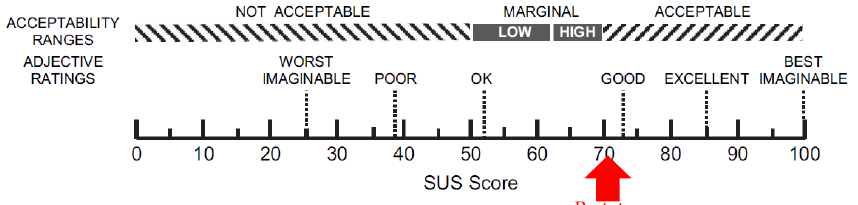
Figure 5. The rating and acceptability of the VET according to the SUS rule-of-thumb standard (adopted from Bangor et al. [41]).